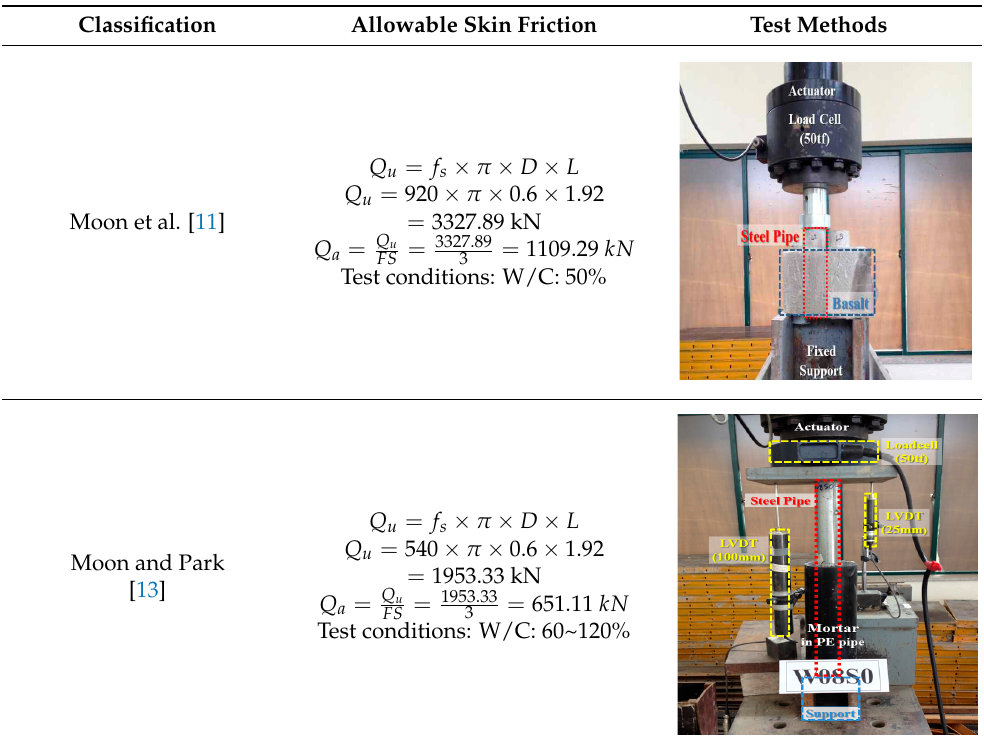
Table 4. Allowable skin friction between tension member and grout.